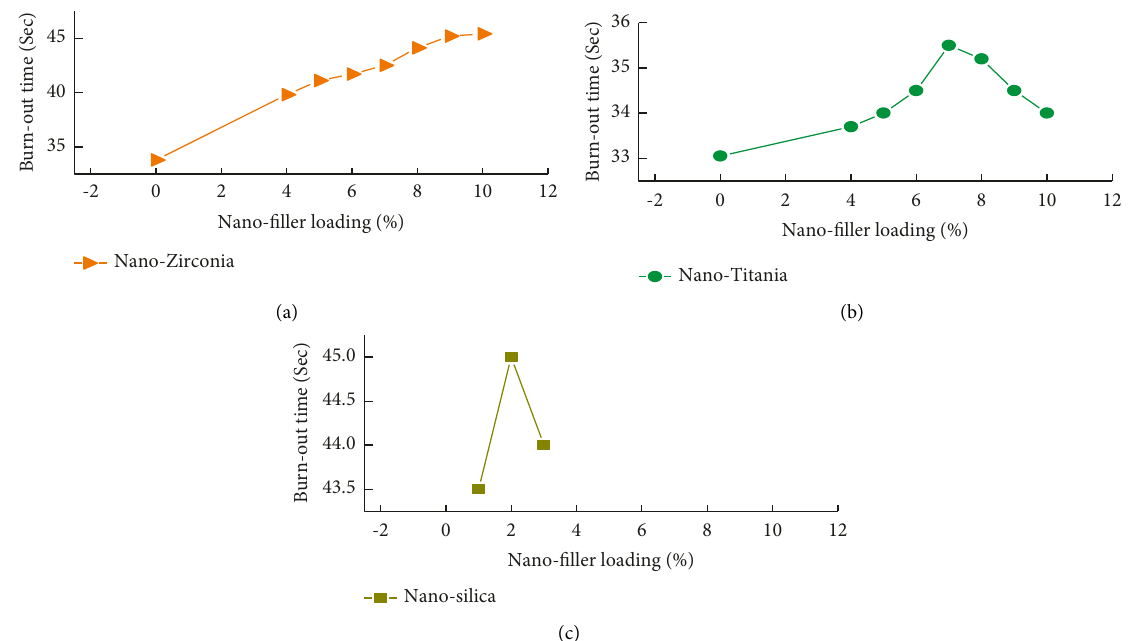
Figure 10: Burnout time as a function of filler loading for the nano C-Ph-composite